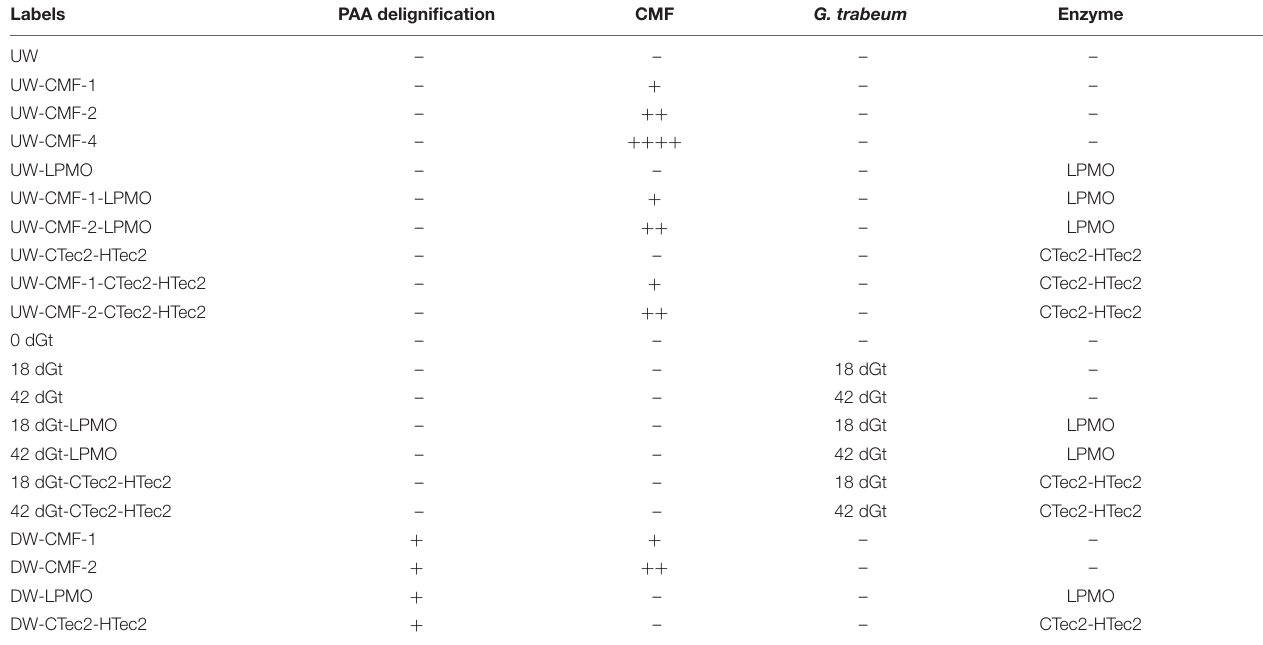
TABLE 2 | Treatments of all wood samples analyzed by